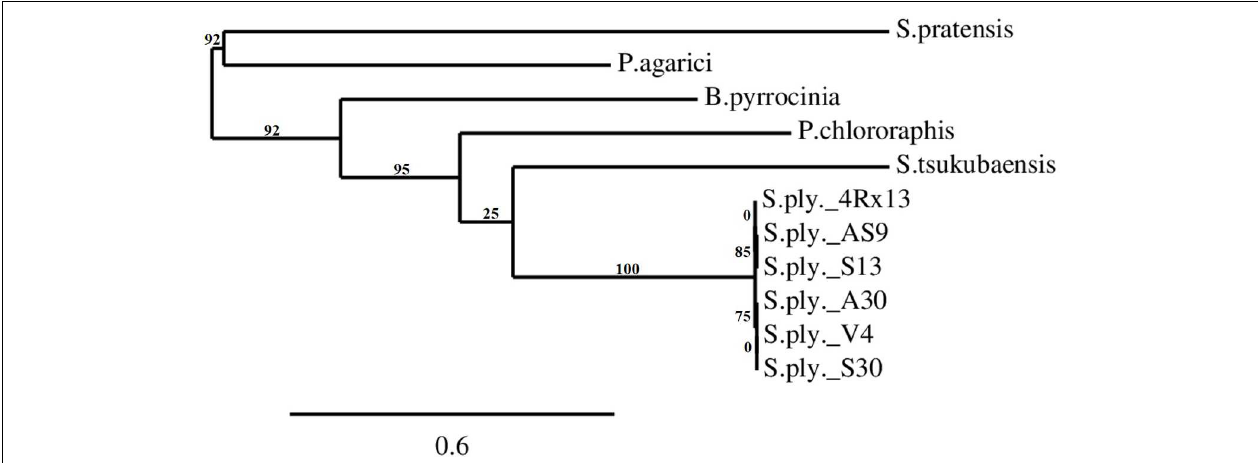
FIGURE 5 | The phylogenetic tree of SOD_c20750 homologs (terpene cyclase) in different bacterial species and isolates. The tree was calculated using phylogeny.fr (Dereeper et al., 2008) based on the protein sequences of the SOD_c20750 of Serratia plymuthica 4Rx13. The protein sequences of the S. plymuthica isolates AS9, AS12, AS13, A30, V4, and S13 were aligned to the sequence of 4Rx13. Streptomyces tsukubaensis , Streptomyces pratensis, Pseudomonas chlororaphis , Pseudomonas agrici, and Burkholderia pyrrocinia were selected as outgroups. The tree was built on the basis of the approximation of the standard Likelihood Ratio Test (aLRT). Numbers indicate branch support